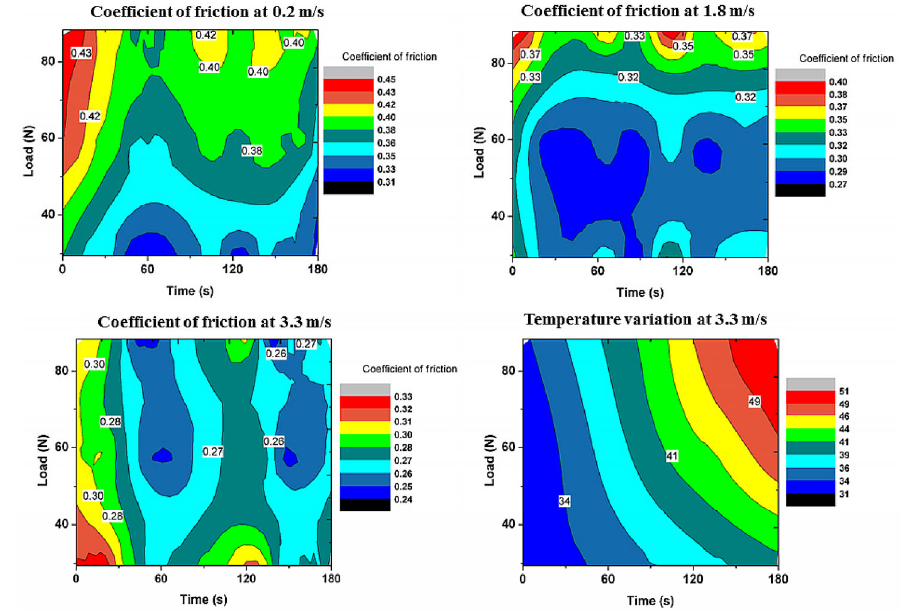
Fig. 6 Variation of the coefficient of friction and temperature for W-II